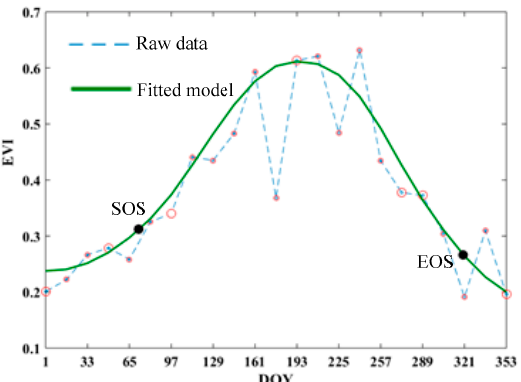
Figure 4. Example of asymmetric Gaussian function curve fitting to raw enhanced vegetation index (EVI) observations plotted against Day of Year (DOY).